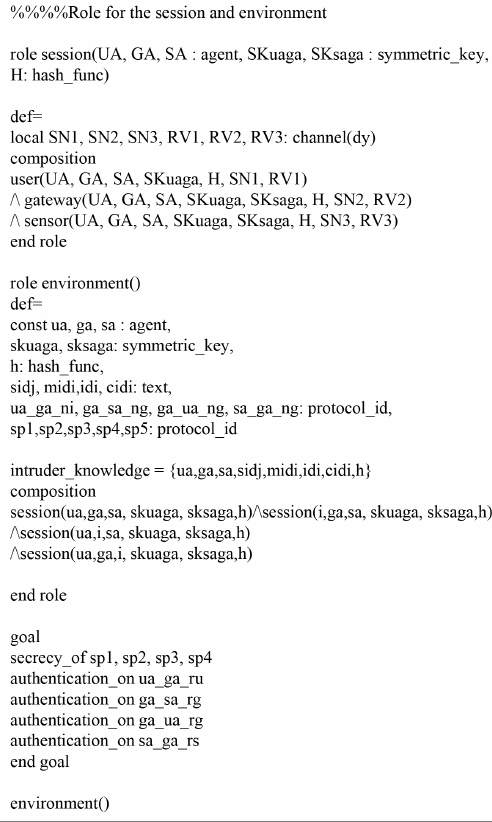
Figure 7. High-Level Protocols Specification Language (HLPSL) syntax for session and